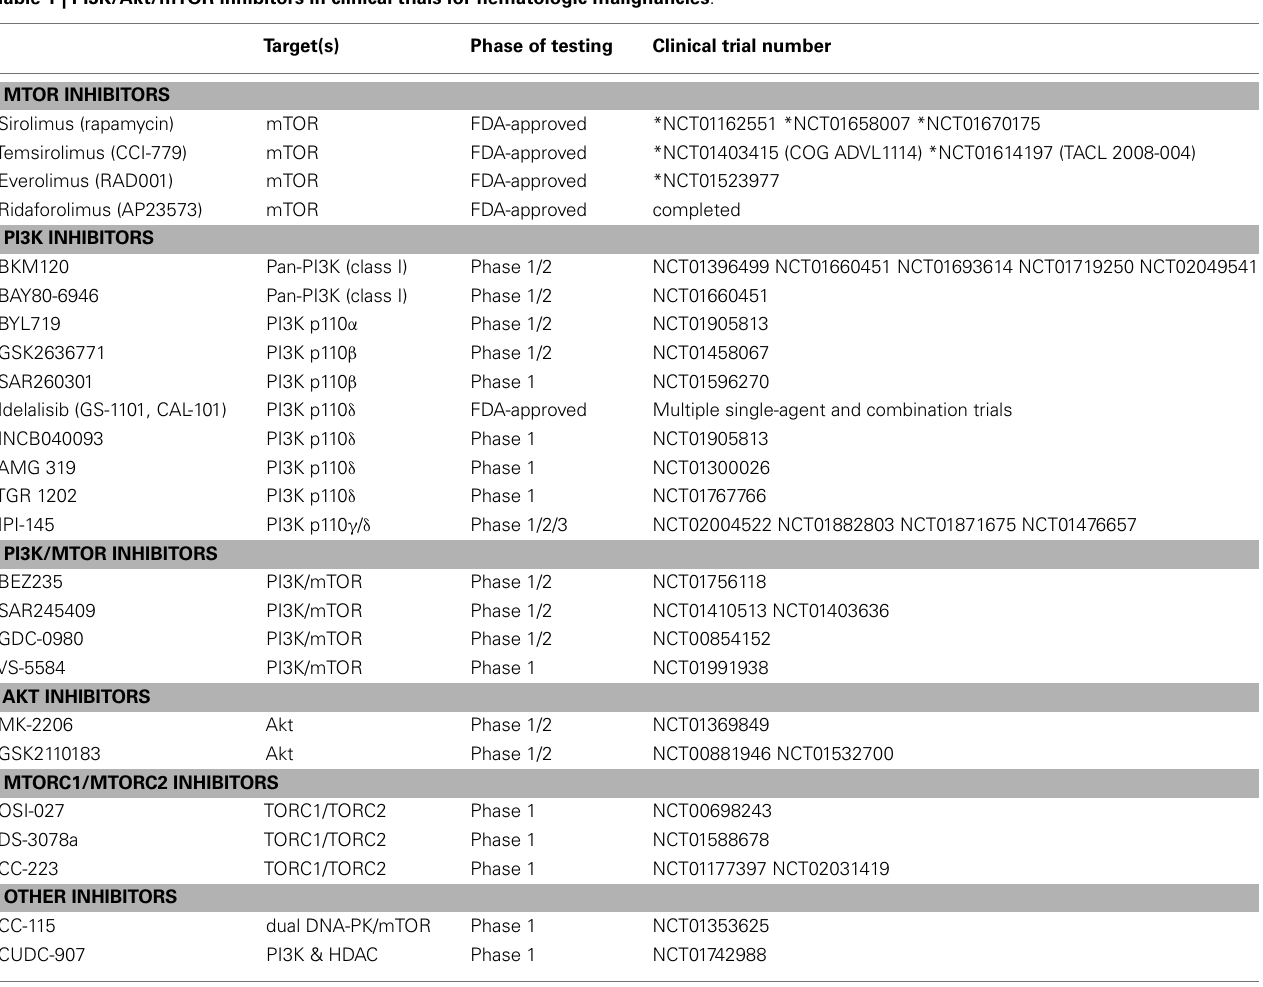
Table 1 | PI3K/Akt/mTOR inhibitors in clinical trials for hematologic malignancies